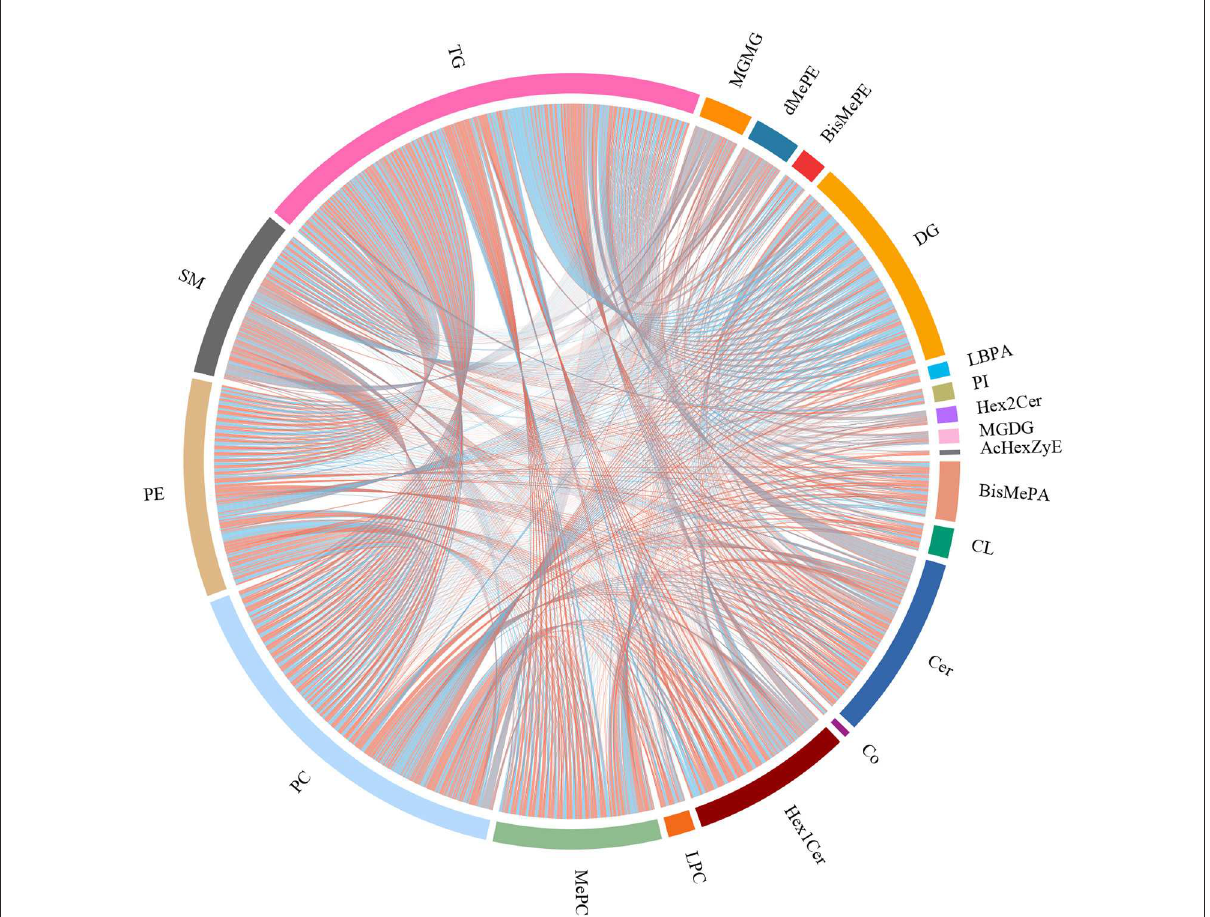
FIGURE4 Correlation analysis between different lipids–chordal graph. The line represents the Pearson correlation information of expression values among the lipids, red represents positive correlation, green represents negative correlation, and the darker the color or thicker the line, the higher the correlation